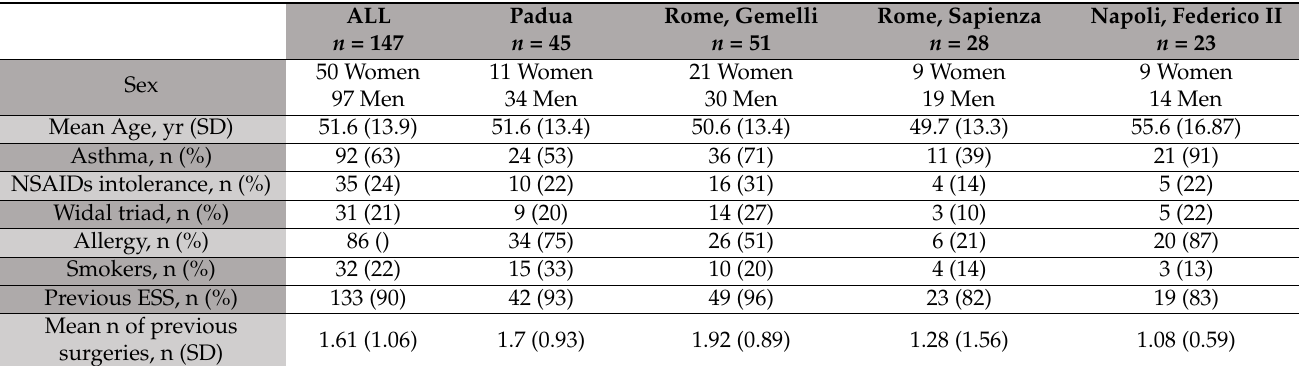
Table 1. Patients’ main clinical characteristics at baseline.